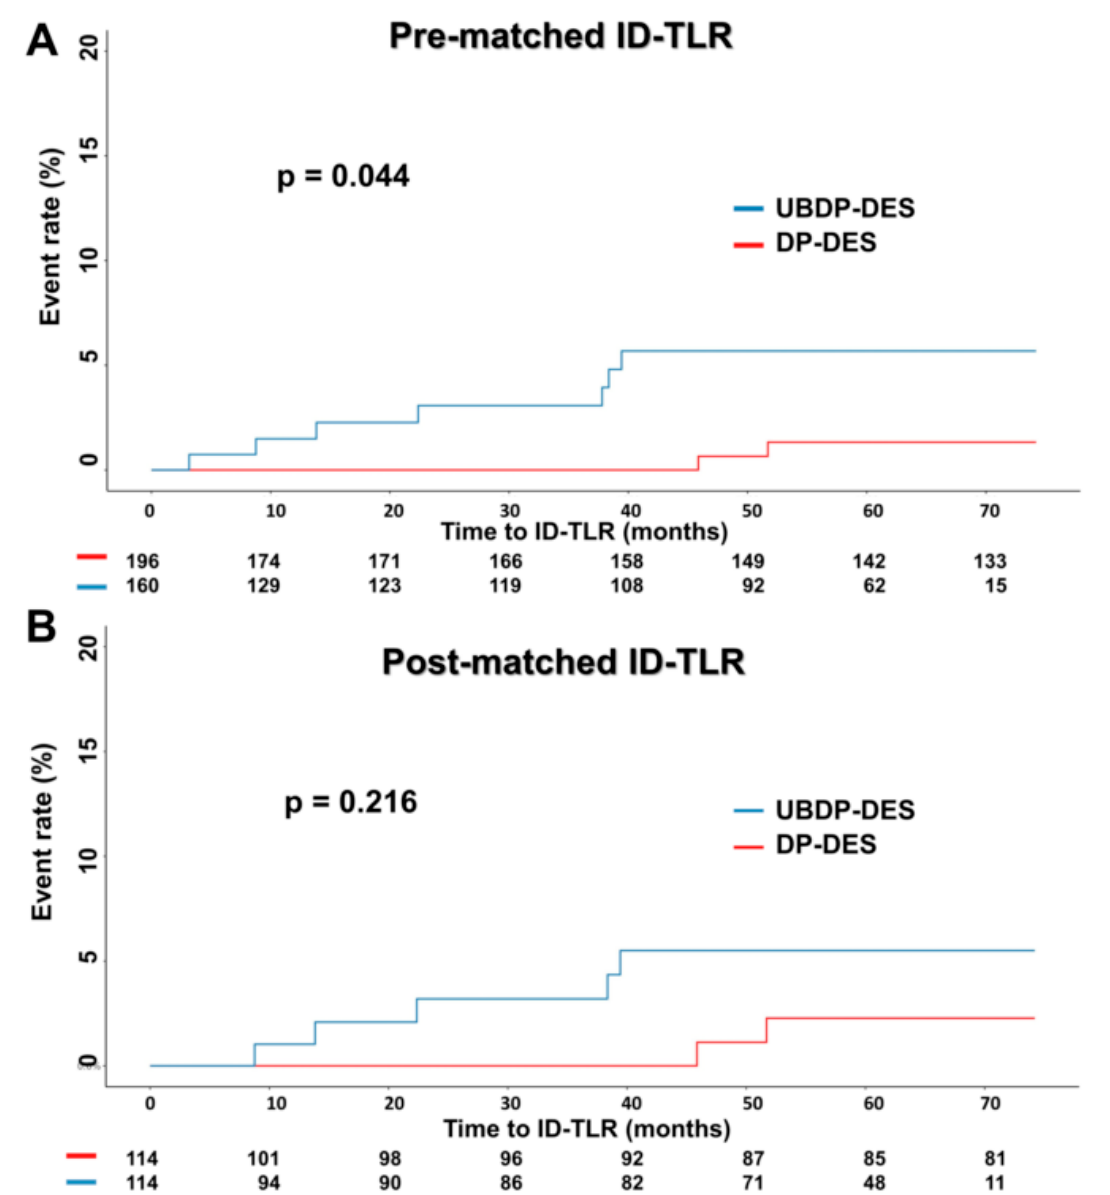
Figure 3. Kaplan–Meier survival curves of ID-TLR ( A ) pre- and ( B ) post-PSM. All abbreviations are listed in Table 1.